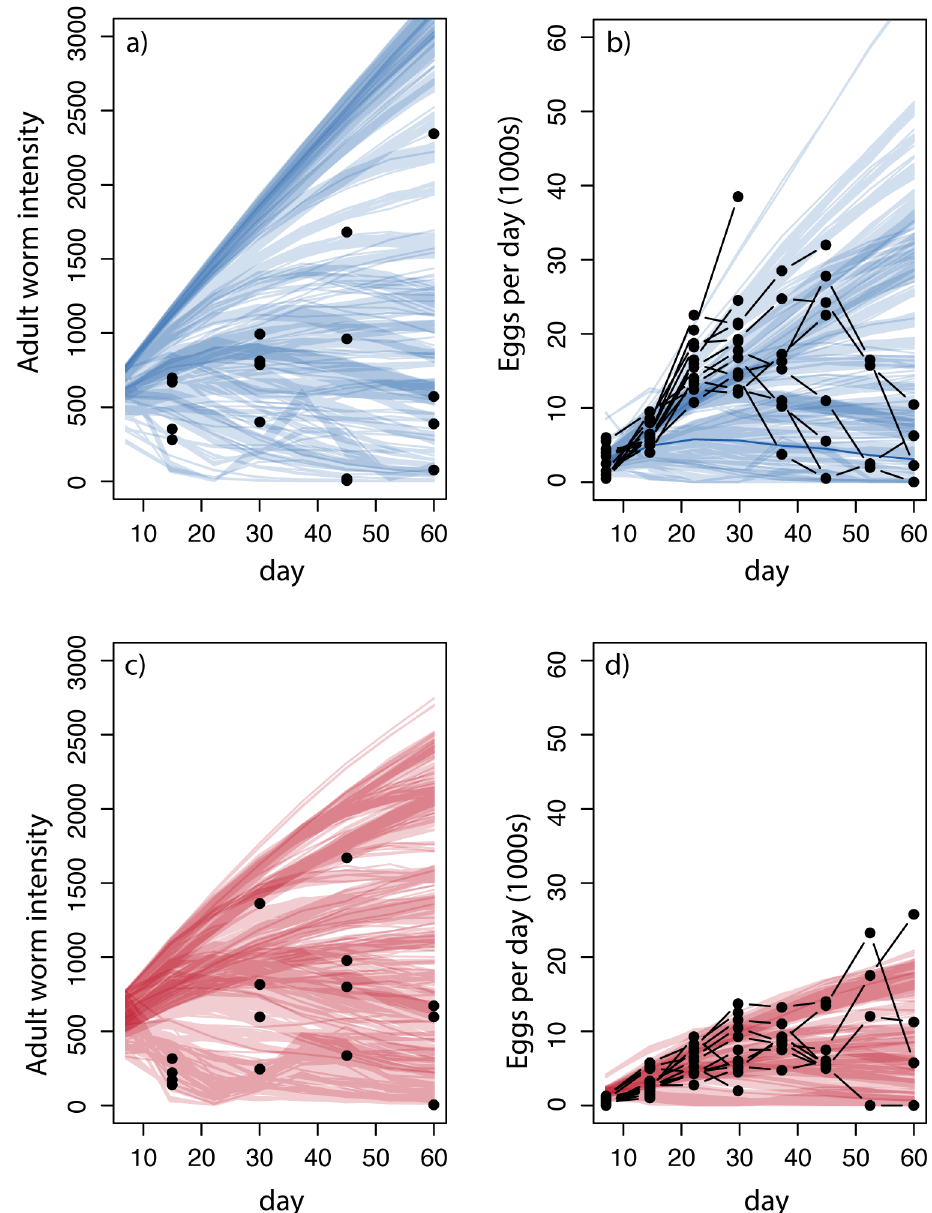
Fig 1. Observed and simulated adult worm intensity and parasite fecundity at each sampling point. (a) Circles give the estimated adult parasite intensity, 4-times the number of worms counted, at each sampling time during the pre- treatment phase. Lines indicate simulated adult parasite intensity each day. Each line reflects a simulation based on a single parameter draw from the posterior density; line shading reflects likelihood weight (darker is higher likelihood); clusters of lines reflect clustering of parameter values for individual animal fits. (b) Circles give the estimated parasite fecundity, EPG divided by 0.03, at each sampling time during the pre-treatment phase. Points are connected indicating repeated observations from a single rabbit. The abrupt truncation of the time series is due to animal sampling. Lines indicate simulated parasite fecundity each day. Shading and clustering of lines are as in (a). (c) Estimated adult parasite intensity for the post-treatment phase. Circles and lines are as in (a). (d) Estimated parasite fecundity for the post- treatment phase.